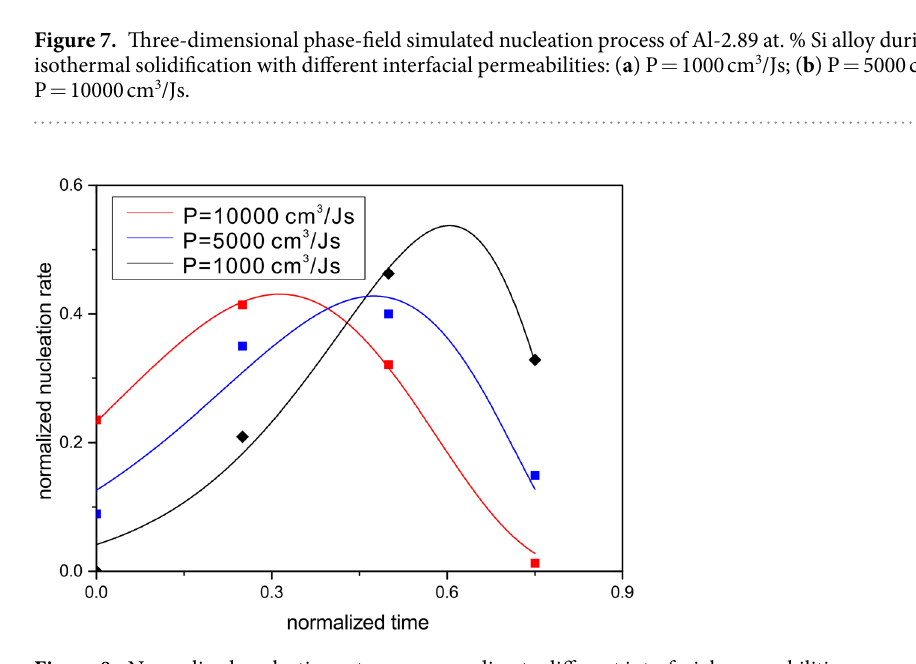
Figure 8. Normalized nucleation rates corresponding to different interfacial